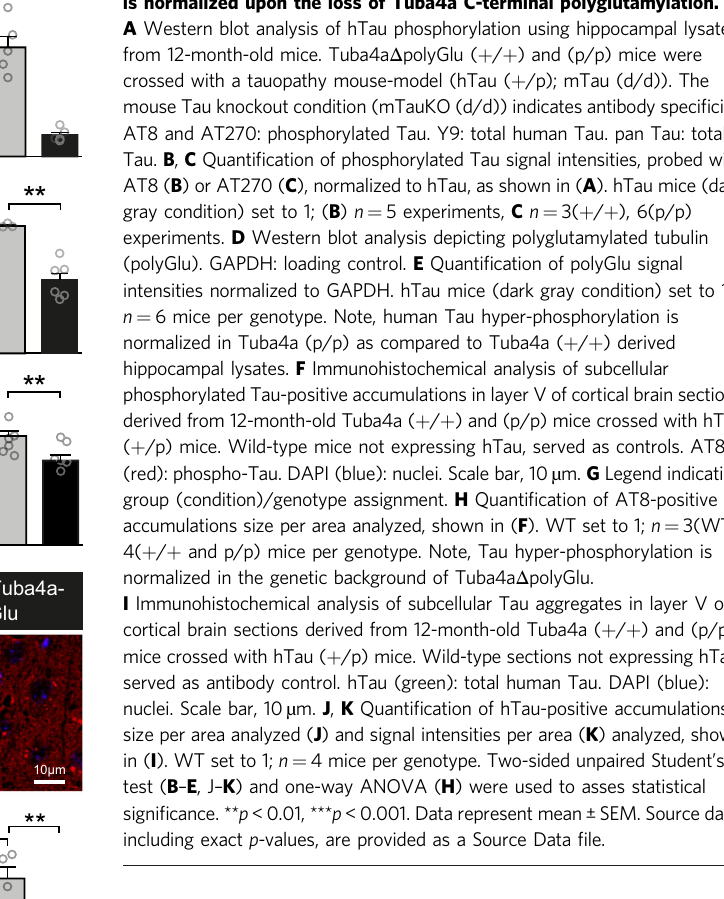
Fig. 10), suggesting that at this stage of analysis neurodegenera- tion is not yet prominent. We, therefore, asked whether the abnormal oligomerization of human hyper-phosphorylated Tau, often referred to as pre-tangles, a premature state of neuro fi brillary tangles (NFTs) 52 , might also be normalized in hTau/Tuba4a Δ polyGlu mice. To this end, we applied TOMA-1 antibodies speci fi c for the detection of oligomeric forms of Tau 53 . Similar to the normalization of hyper-phosphorylated Tau (Fig. 7F – H and Supplementary Fig. 9A – C), hTau/Tuba4a Δ polyGlu animals, lacking Tuba4a polyglutamylation revealed normalization of Tau oligomeric assemblies, as compared to hTau tauopathy mice (Fig. 8A – C). Human Tau oligomerization could further be con fi rmed in a western blot-based experiment using the hTau antibody. As expected, WT and mTauKO animals did not display any hTau expression (Fig. 8D, white and light gray condition), whereas hTau animals displayed bands at the higher molecular weight (MW) above 75 kDa (Fig. 8D, dark gray condition), indicative of Tau oligomers. Consistent with the TOMA-1 immunostainings (Fig. 8A – C), the intensity of these hTau-speci fi c high MW signals, was signi fi cantly decreased in hTau/Tuba4a Δ po- lyGlu animals lacking Tuba4a polyglutamylation (Fig. 8D, E, black condition). Finally, the use of the TOMA-1 antibody in dot blot assays corroborated Tau oligomers in hTau animals (Fig. 8F – H, dark gray condition) that were signi fi cantly reduced in hTau/ Tuba4a Δ polyGlu mice (Fig. 8F – H, black condition). Together, our data point to Tuba4a polyglutamylation as a potential parameter to preclude the hyper-phosphorylation and oligomerization of Tau (Fig. 10).